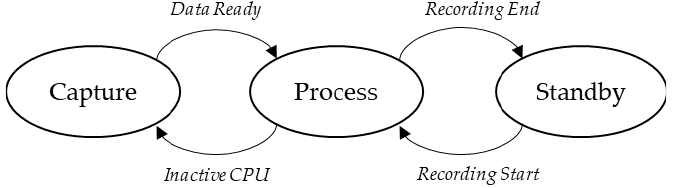
Figure 10. Dynamic power management